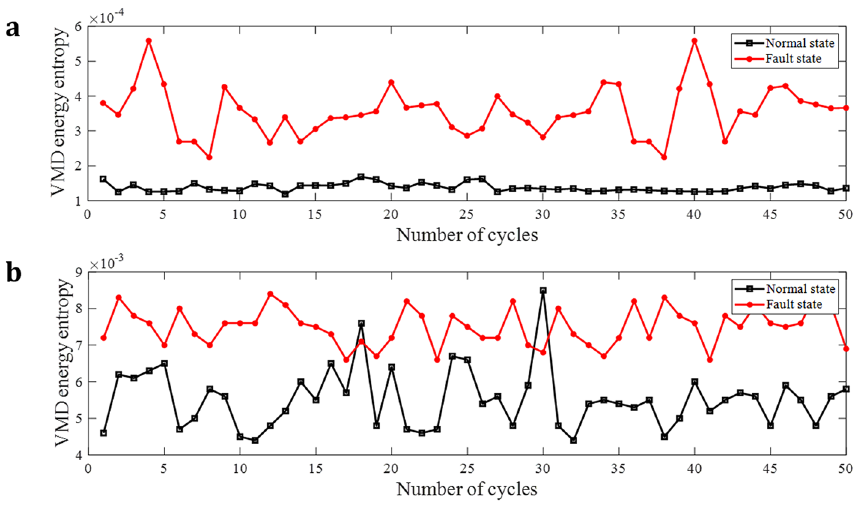
Figure 7. VMD energy entropy of current in three-phase motor circuit and frequency converter circuit. ( a ) VMD energy entropy of current in three-phase motor circuit. ( b ) VMD energy entropy of current in frequency converter